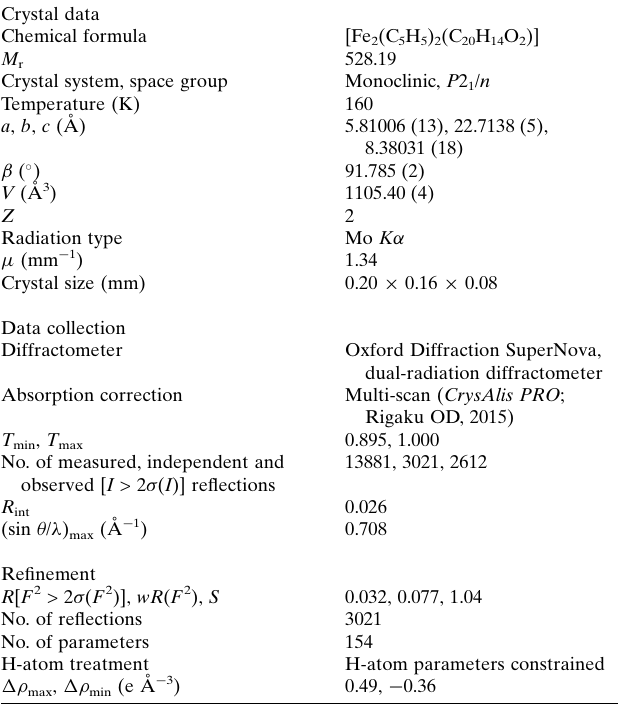
Table 2 Experimental details. Crystal data Chemical